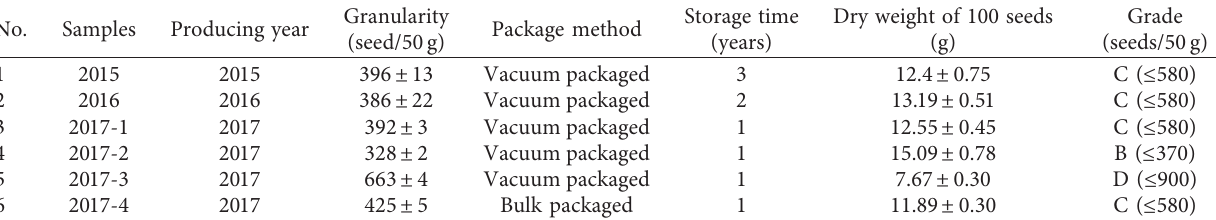
Table 1: The profiles of dried Lycium fruits samples.